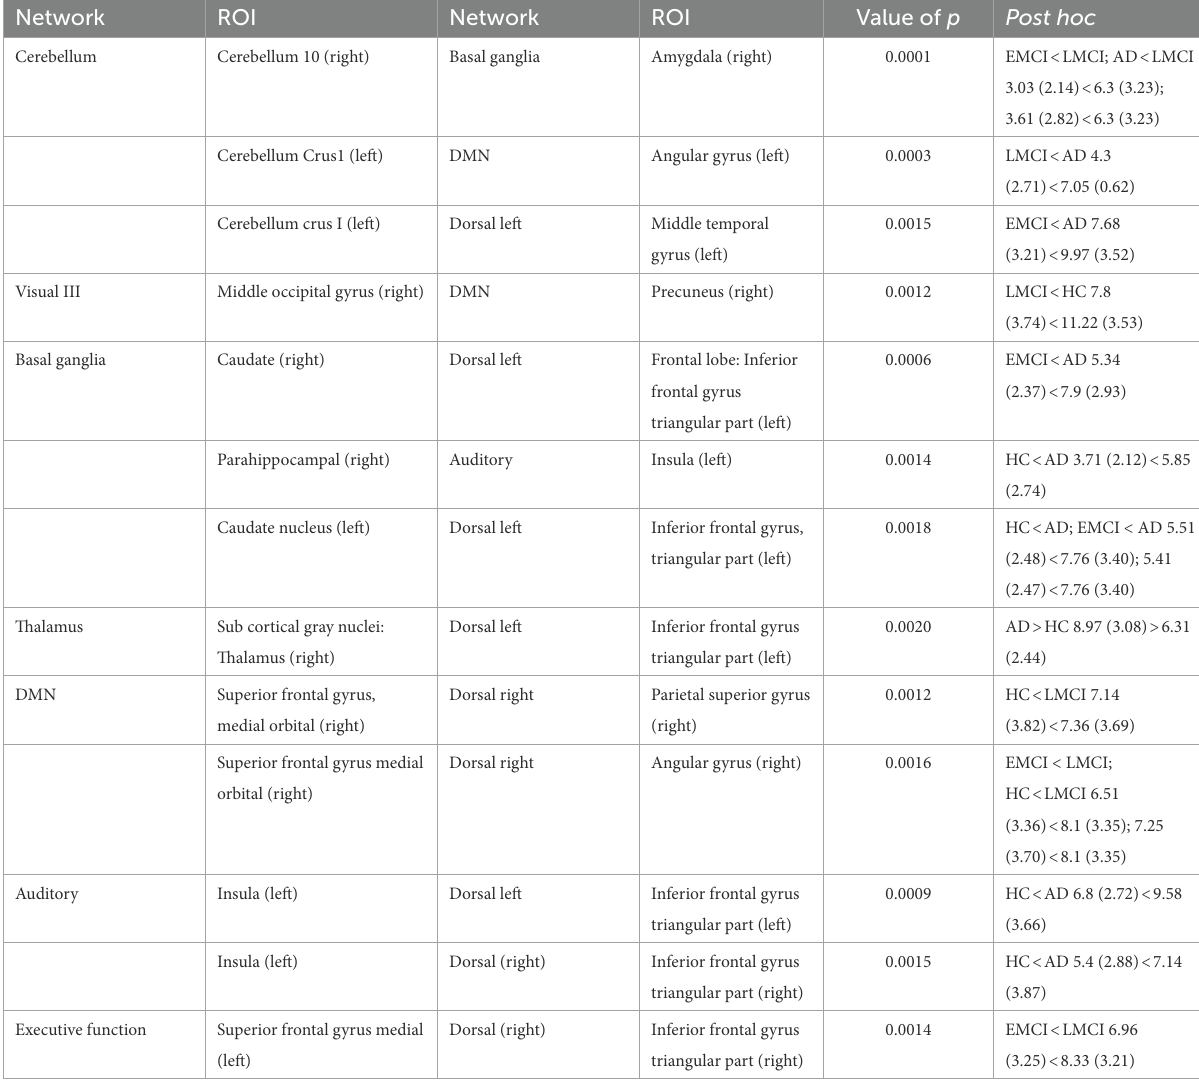
TABLE 5 Differences in FC using the point process